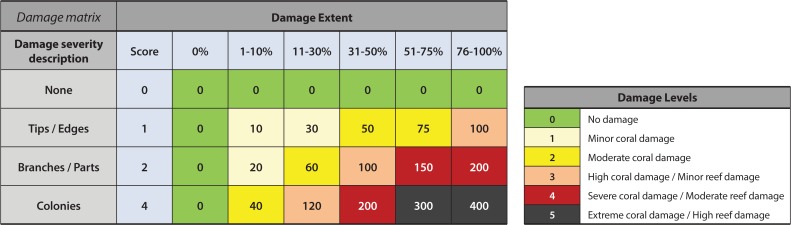
Cyclone damage matrix.Damage extent and severity scores in light blue represent the survey area damaged (Damage extent) and the dominant type of colony-level damage observed (Damage severity description). Damage levels 1, 2 and 3 relate to coral damage, while 4 and 5 relate to reef structural damage (see colour scale on right). Representative photographs of each damage level are shown in Fig. 4 with damage descriptions.